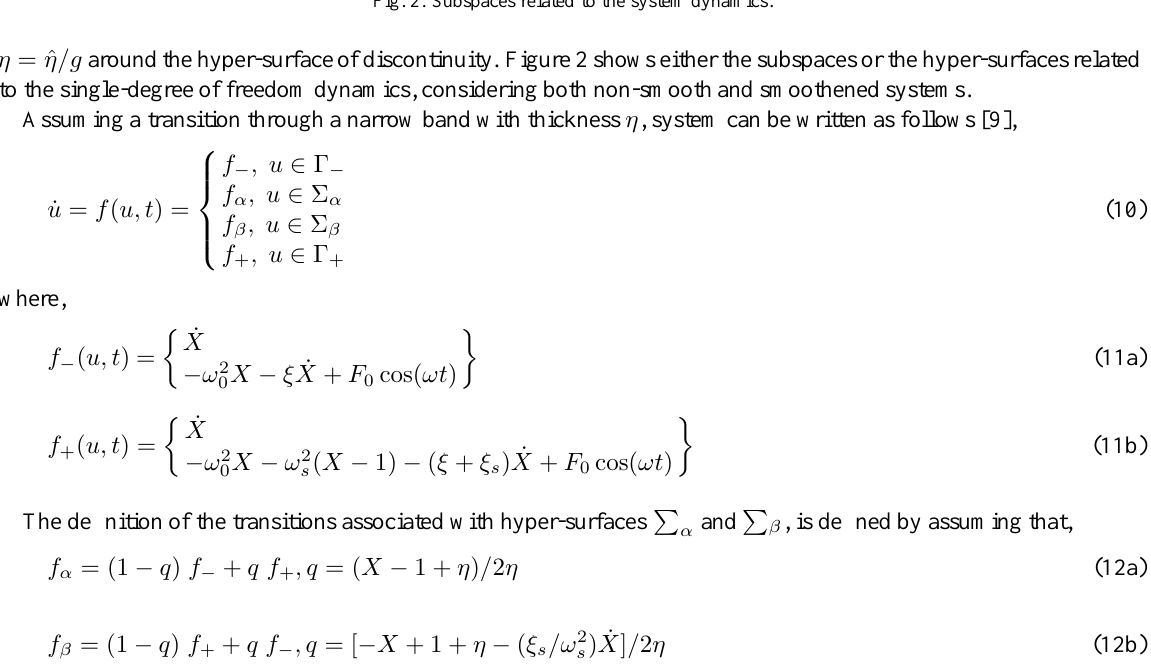
Fig. 2. Subspaces related to the system